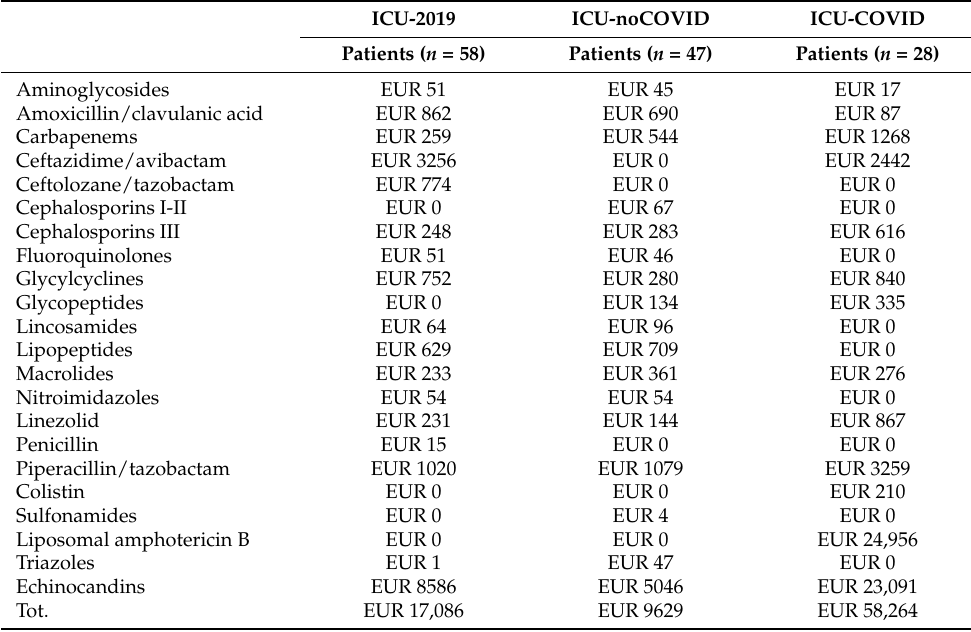
DDD: defined daily dose. Table 6. Costs of specific antibiotic drugs in three ICU